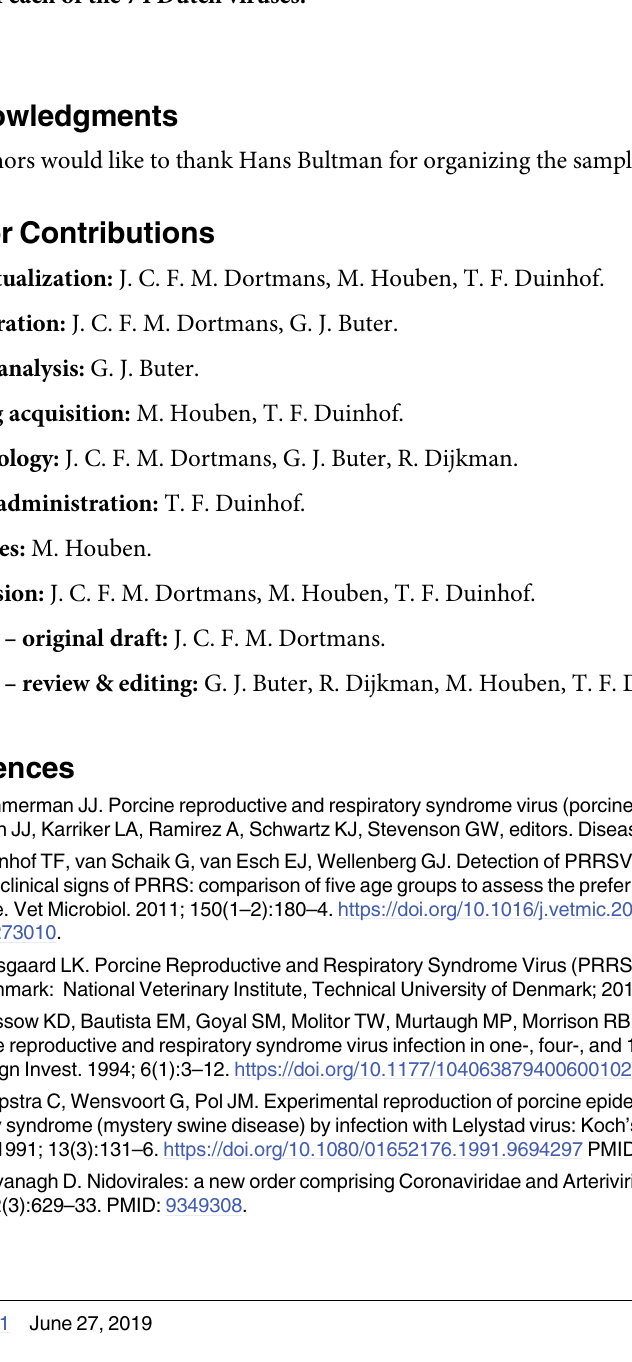
S2 Table. Genetic similarity (%) with Lelystad virus. S3 Table. Individual ORF length of each of the 74 Dutch viruses. S4 Table. Putative N-glycosylation sites and signal peptides of ORF2, ORF3, ORF4 and ORF5 of each of the 74 Dutch